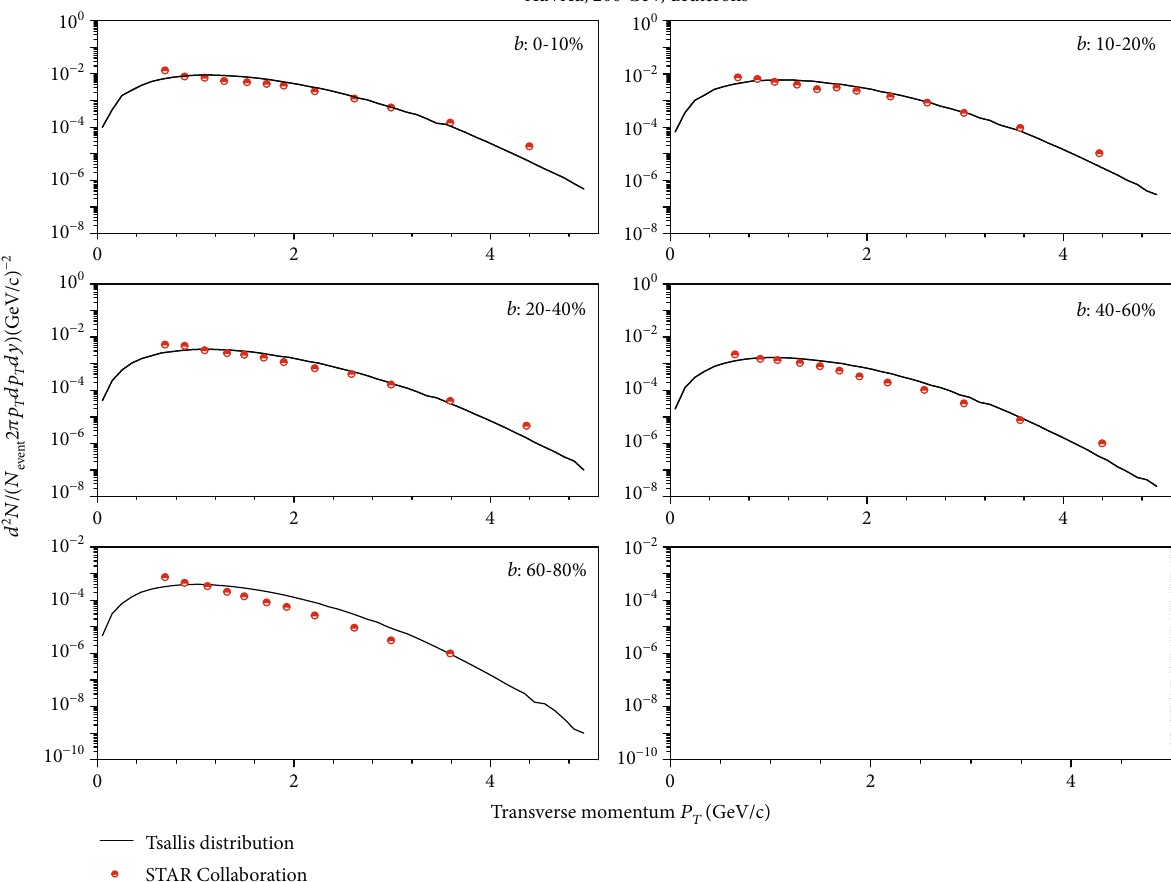
ffiffiffiffiffiffiffi p = 200 GeV for 0-10%, 10-20%, 20-40%, 40-60%, and 60-80% s NN ffiffiffiffiffiffiffi p = 62 : 4 GeV for 0-10%, 10-20%, 20-40%, 40- s NN